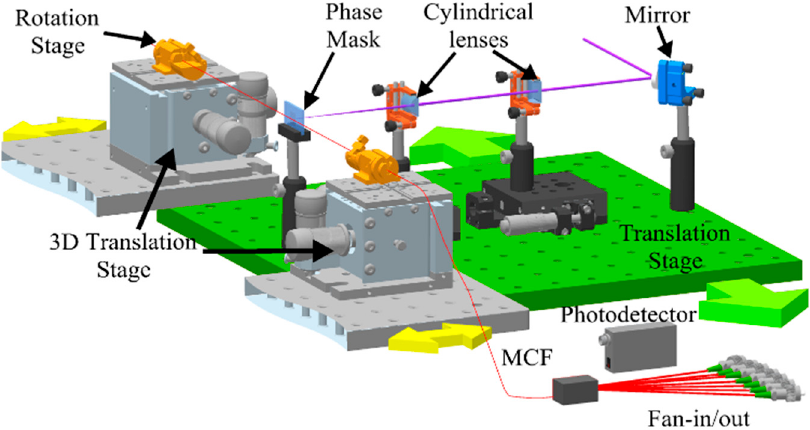
Figure 5. General scheme of the fiber Bragg grating inscription setup [51].